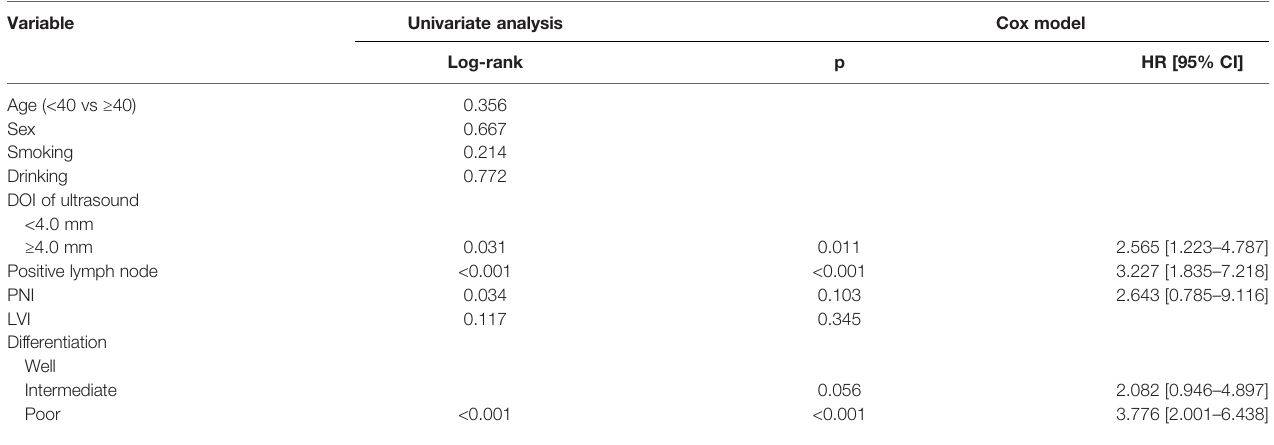
TABLE 3 | Univariate and cox model analyses of regional control survival in patients with ultrasound derived DOI ≥ 4.0 mm. Variable